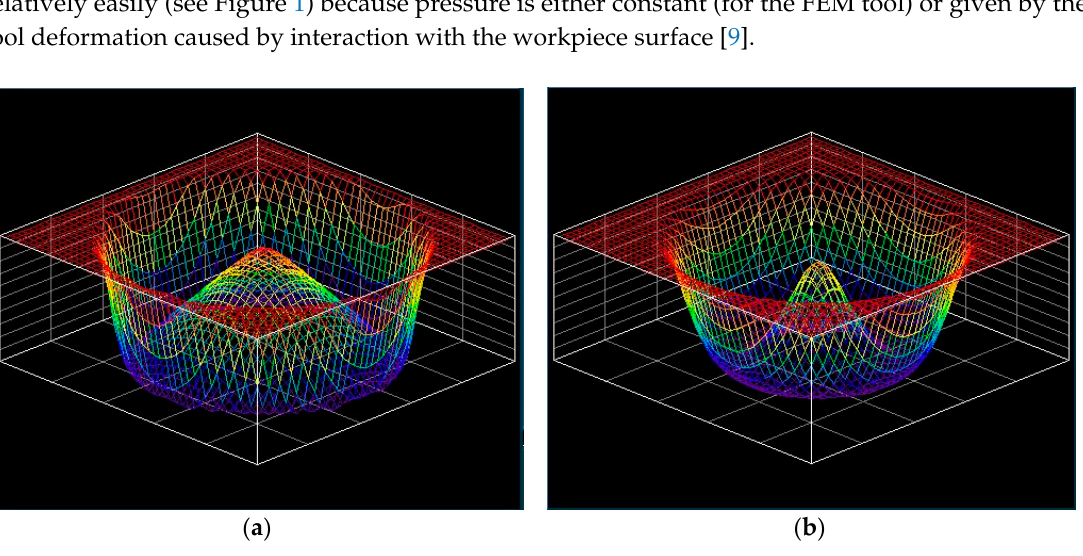
Figure 1. Material removal simulation for spherical tool with radius R1O mm for tool speed 800 1 / min— flexible elastic membrane (FEM) with pressure of 1 bar ( a ); viscoelastic head (VEH) with ideal elastic behavior: elastic modulus of 10 MPa and relative deformation of 3% ( b ).